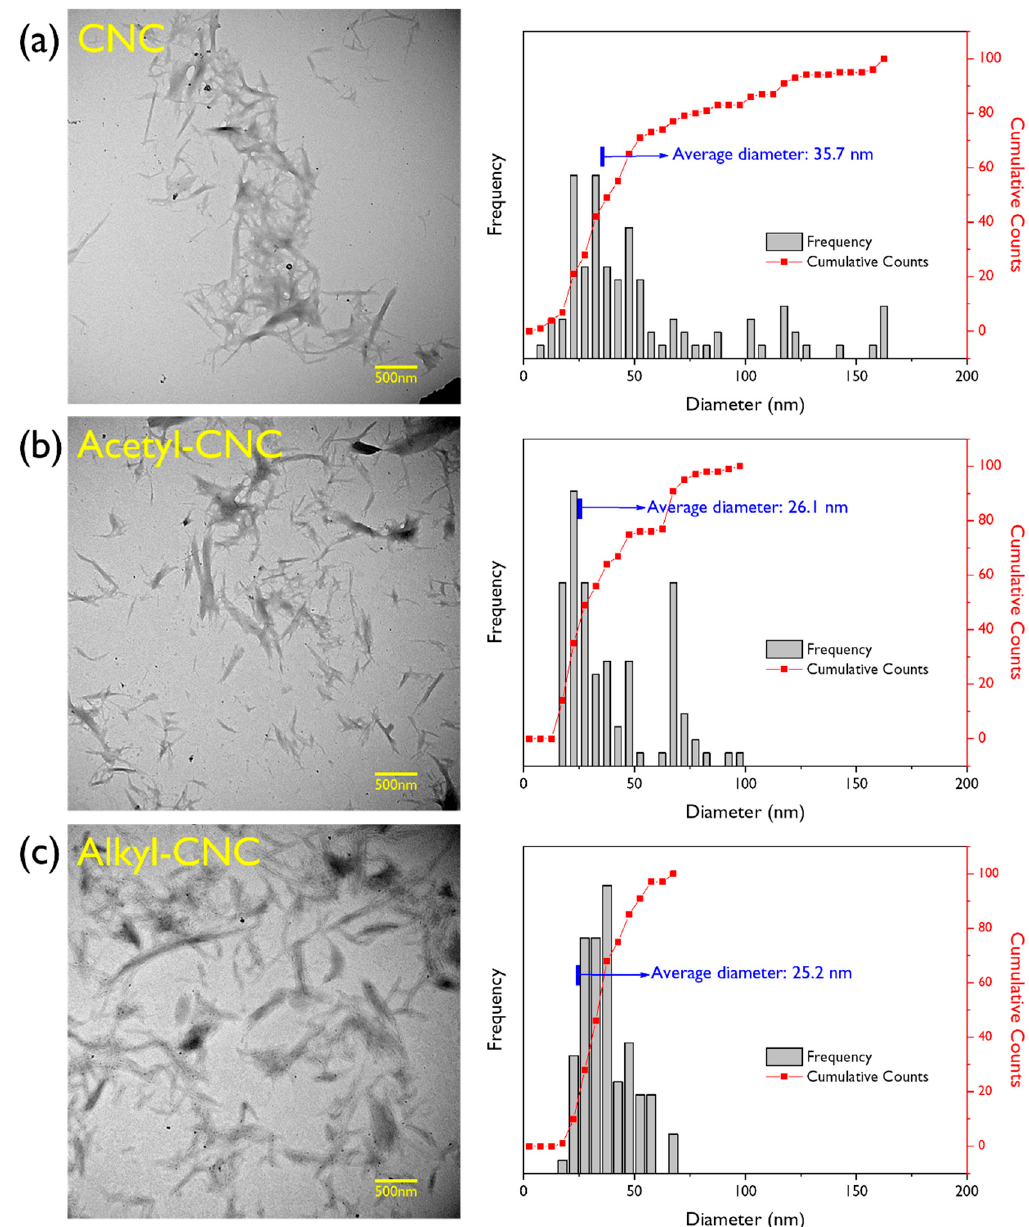
Figure 2. TEM images and diameter distributions of ( a ) CNC, ( b ) acetyl-CNC, and ( c ).